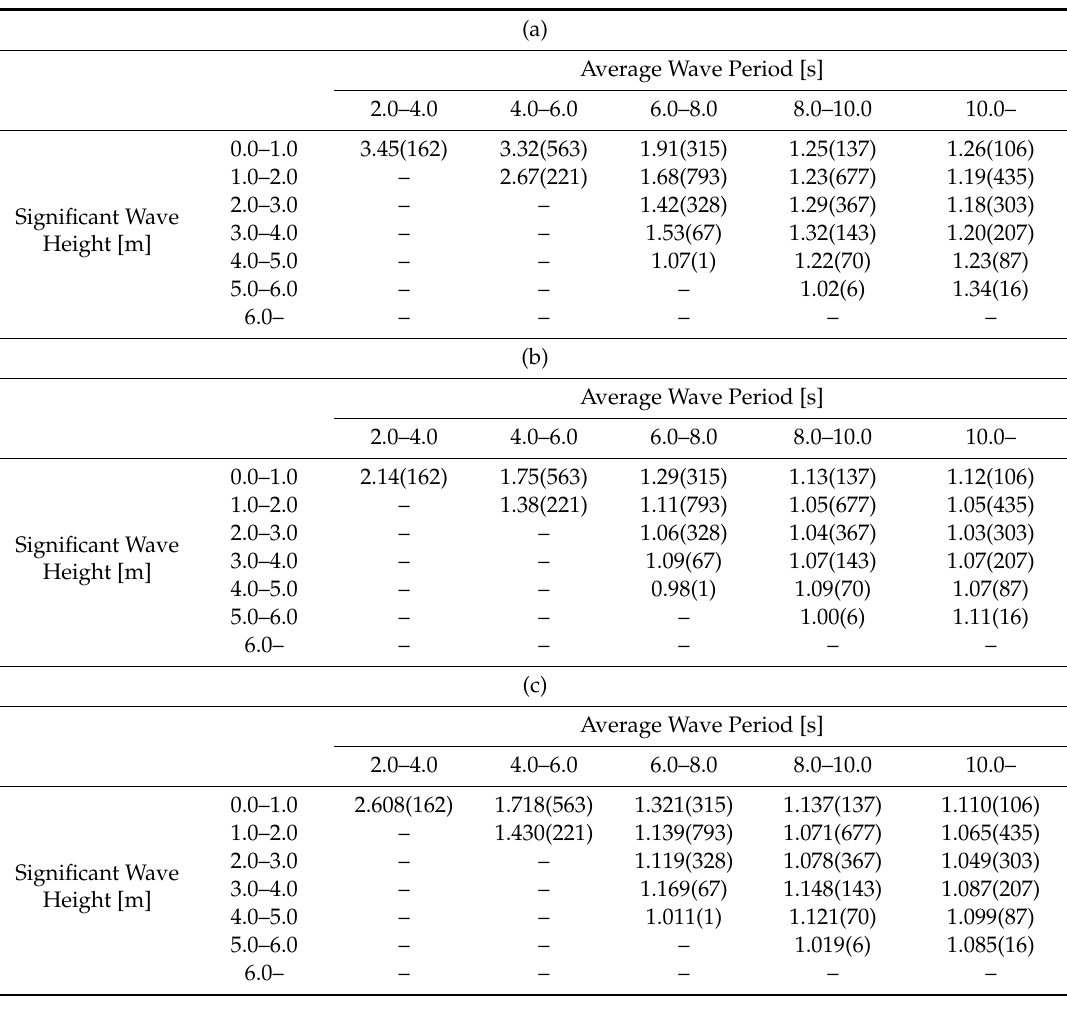
Table 4. Statistics table of whipping factor in bow quartering sea, ( a ) vertical bending component, ( b ) torsional component, ( c ) horizontal bending